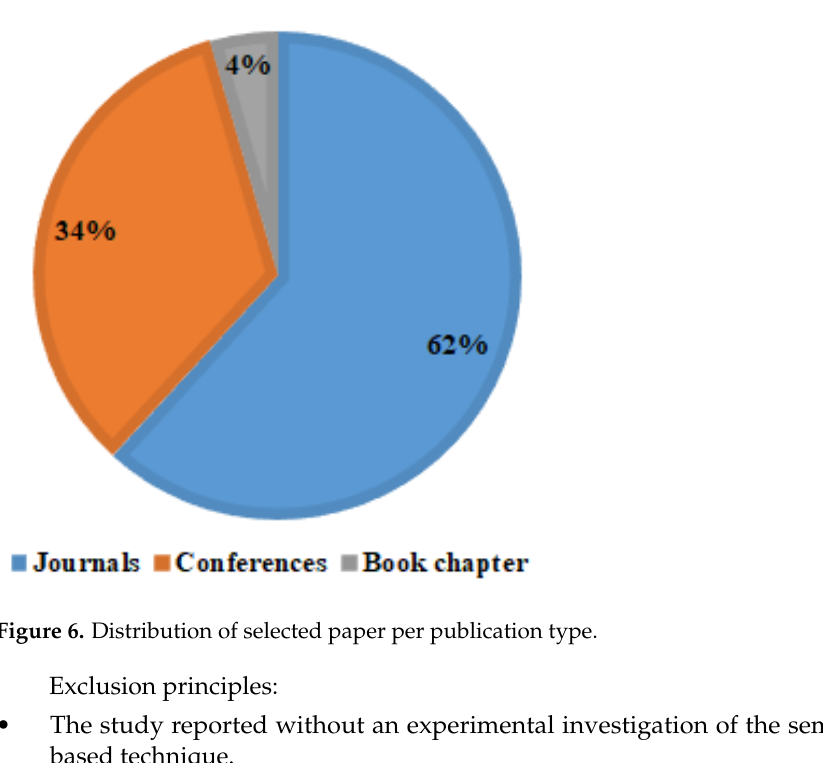
Figure 5. Distribution of selected paper per library.